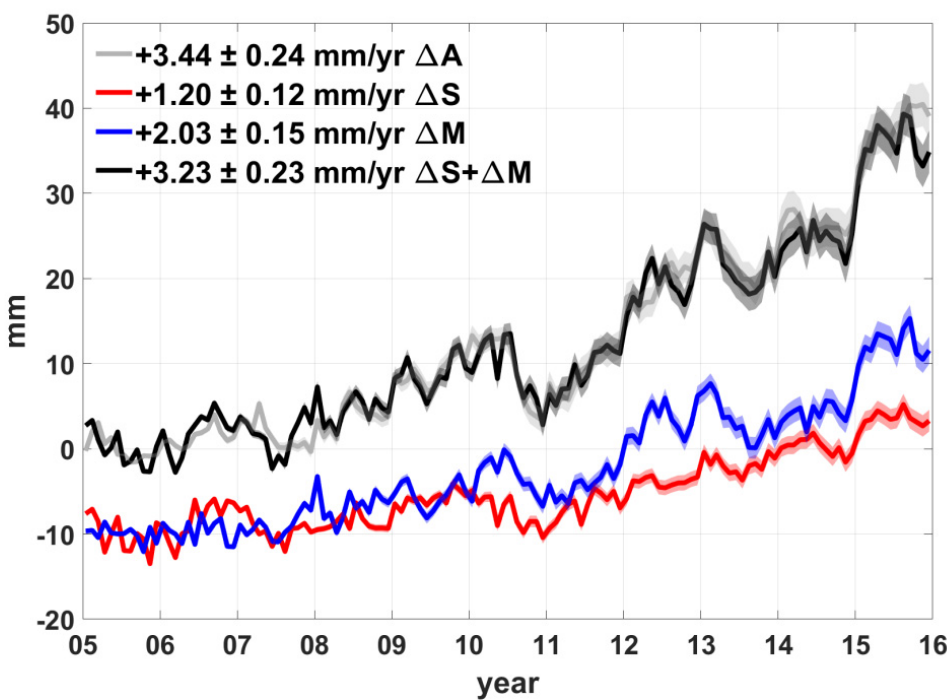
Figure 3. Similar to Figure 2, but from averaging over consistent data coverage 𝐷′ as defined in Equation (5).